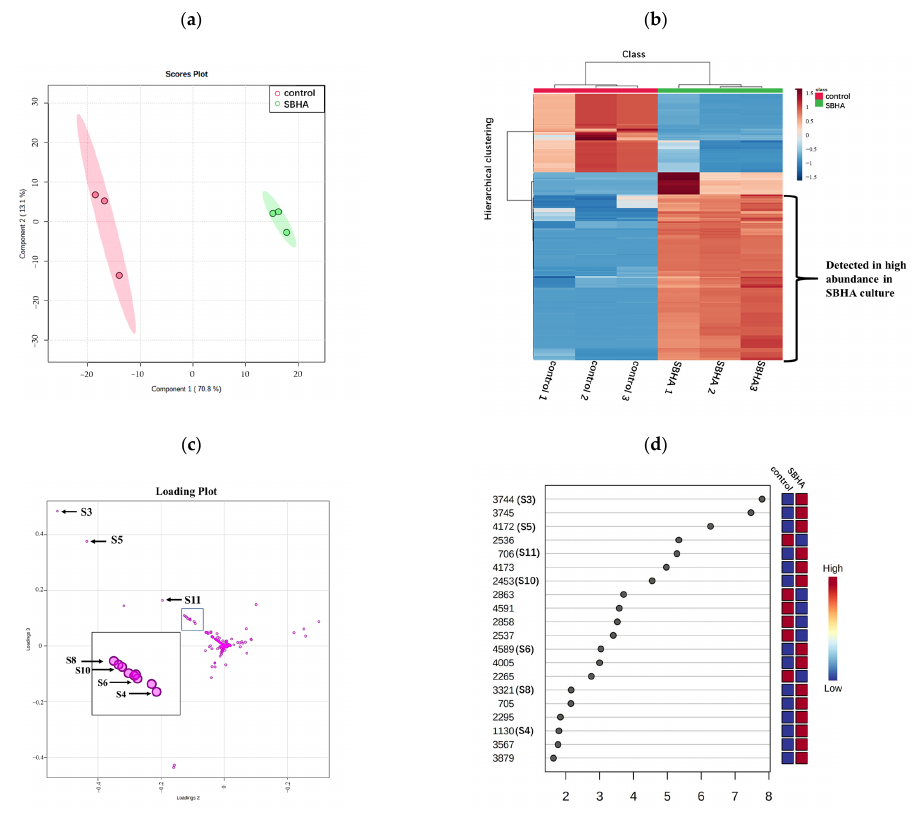
Figure 2. The PLS ‐ DA plot, heatmap of metabolomics data and the VIP score of control and SBHA ‐ regulated A. aculeatus DL1011. ( a ) The scores plot of the data analyzed by LC ‐ MS/MS. ( b ) Hierar ‐ chical clustering analysis (HCA) of the 132 most significantly variable features among the samples corresponding to the 2 different groups represented on a heatmap (ranging from red color for high ‐ abundance to blue for low ‐ abundance). ( c ) The loading plot of the data analyzed by LC ‐ MS/MS. ( d ) The top compounds ranked based on VIP score. The colored boxes on the right indicate the relative concentrations of the corresponding metabolites in each group.